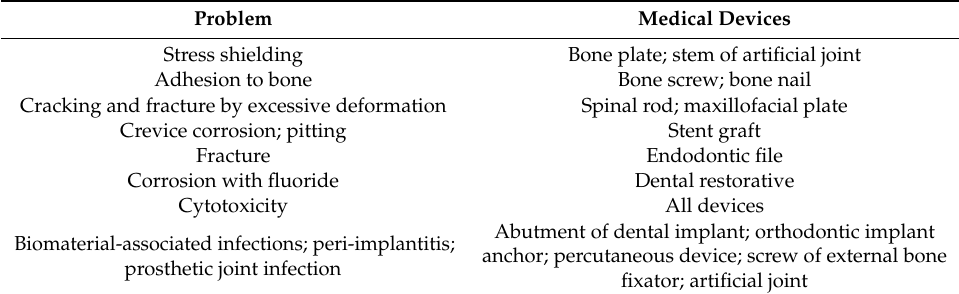
Table 1. Current clinical issues related to Ti use in the